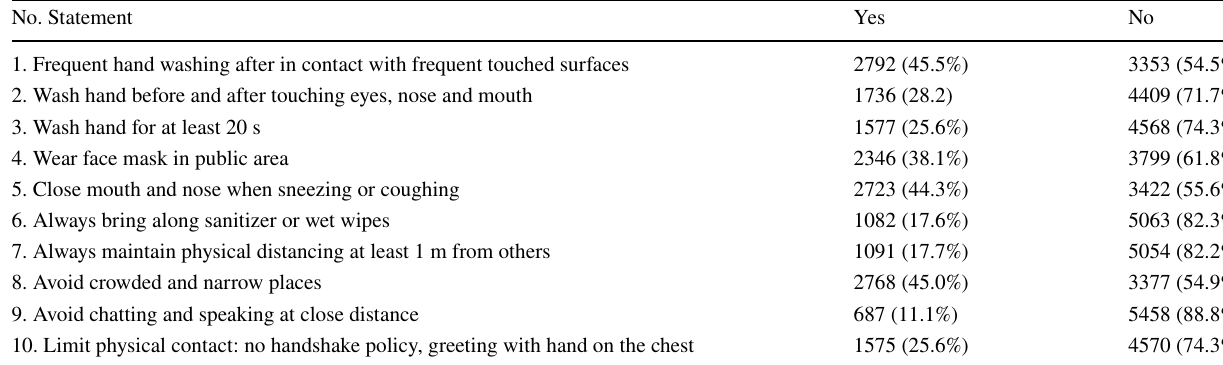
Table 7 Descriptive data of practice of preventive measures during the coronavirus disease 2019 (COVID-19) pandemic No. Statement